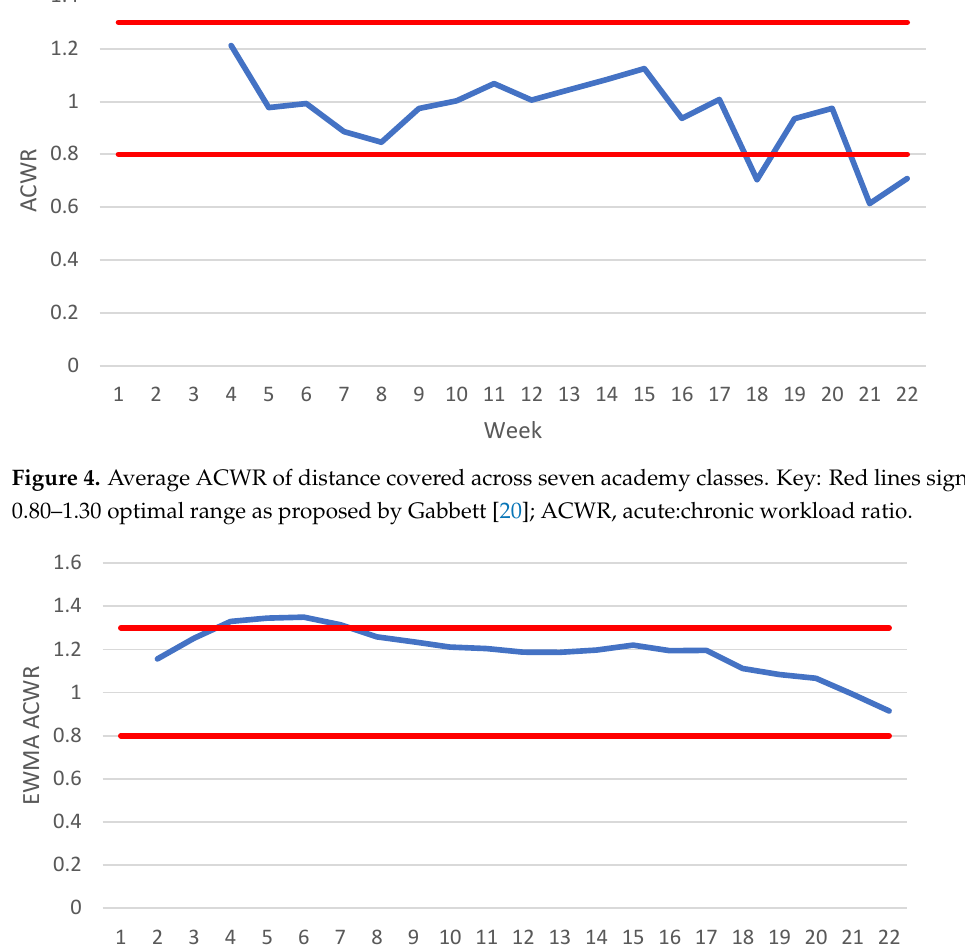
Figure 5. Average EWMA ACWR of distance covered across seven academy classes. Key: Red lines signify 0.80–1.30 optimal range as proposed by Gabbett [20]; EWMA ACWR, exponentially weighted moving average acute:chronic workload ratio.